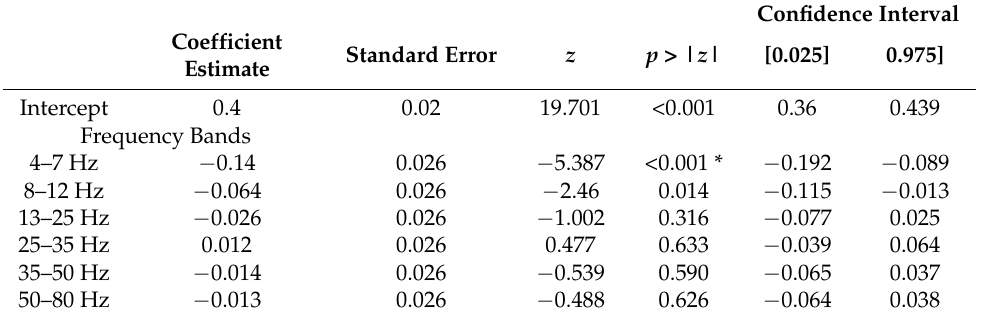
Confidence Interval